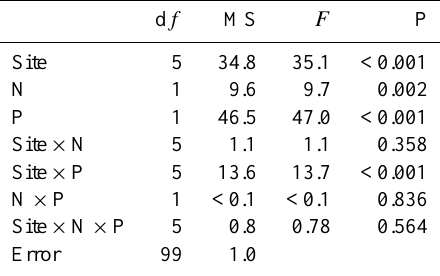
Table 1. Results of 3-way ANOVA of site, nitrogen (N), and phos- phorus (P) addition on the carbon stock in aboveground seagrass